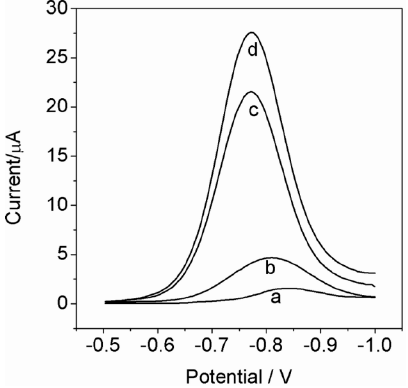
Figure 3 . Differential pulse voltammetric (DPV) responses of the ( a ) bare SPCE, ( b ) imprinted PATP/SPCE, ( c ) conventional one-step electropolymerized imprinted PATP/AuNPs/SPCE, and ( d ) self-assembly directed electropolymerization imprinted PATP/AuNPs/SPCE in the presence of 50 µM PO in HAc–NaAc (pH 5.0).